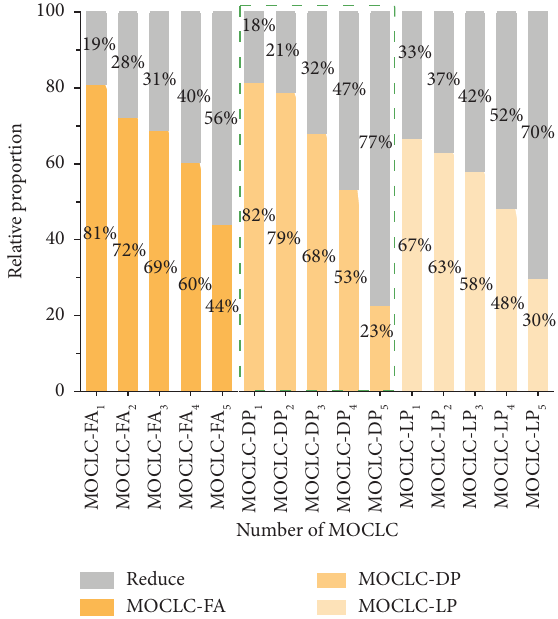
Figure 3: Efect of mineral admixture with diferent types and contents on compressive strength of